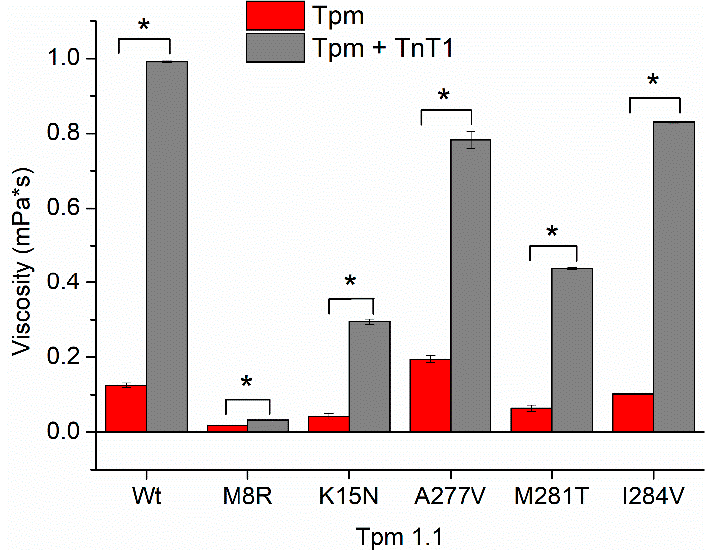
Figure 4. Excess viscosities of Tpm mutant solutions in the presence or absence of cardiac troponin T fragment (TnT1) over buffer viscosity. * Statistical differences in the excess viscosity of Tpm and Tpm + TnT1, p < 0.05.